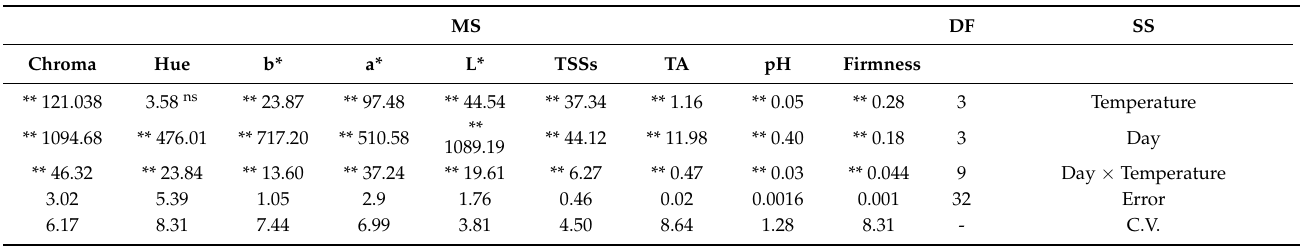
solids, TA = titratable acidity .